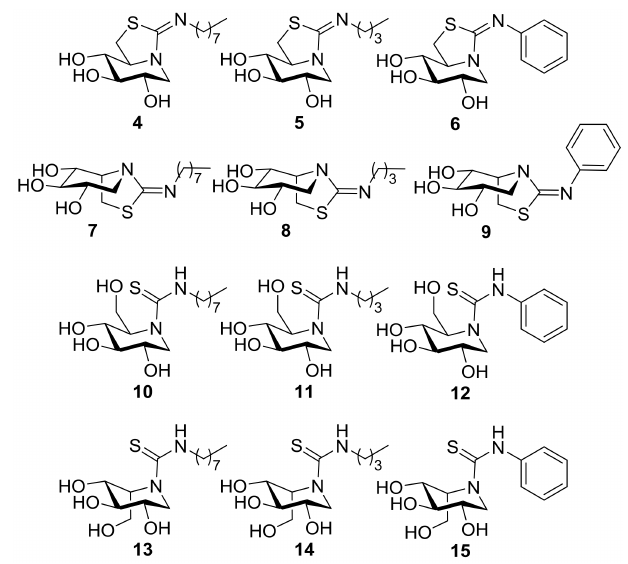
Figure 2. Structures of the new sp 2 -iminosugars prepared in this